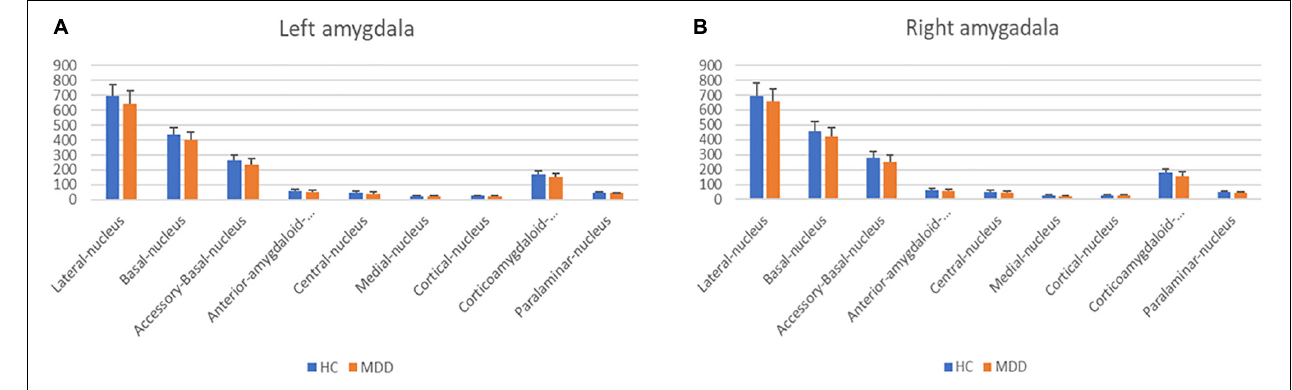
FIGURE 2 | Subregion volumes in amygdala at left (A) and right (B) . Bar charts show the mean amygdala subregion volumes (mm 3 ) of 77 HC (Blue) and 76 MDD (Orange). Vertical bars mean standard deviations. Linear regression analyses showed no significant difference in all subregions between HC and MDD adjusted for total intracranial volume, age, and sex ( p > 0.05). HC, healthy controls; MDD, Major depressive disorders.